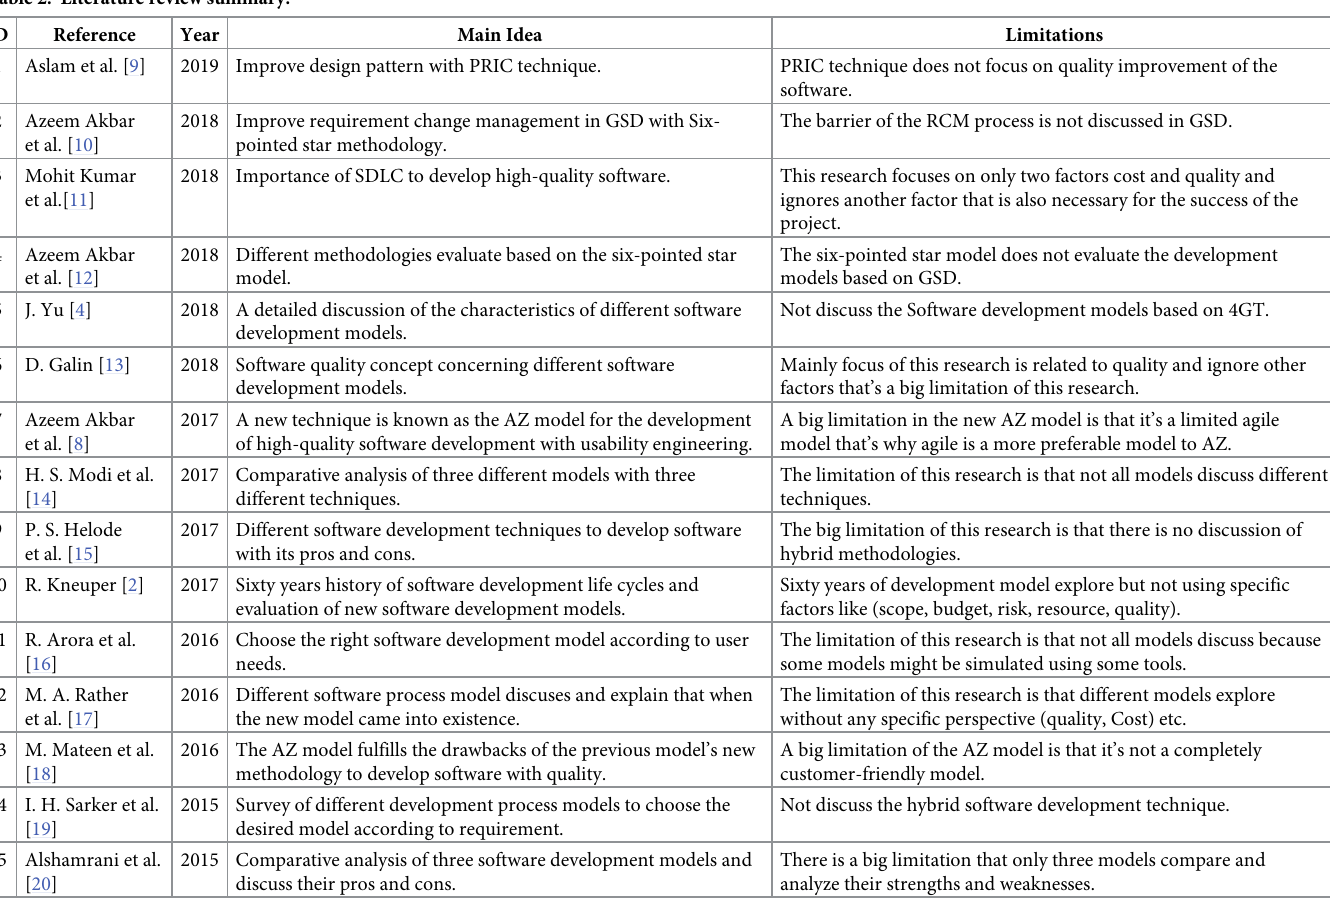
Table 2. Literature review